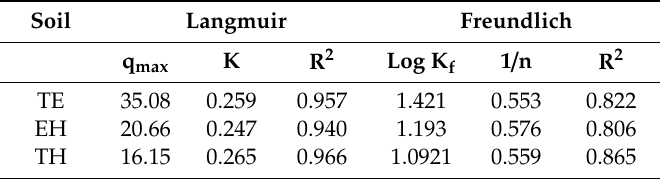
Table 2. Langmuir and Freundlich parameters for the investigated soils. Soil Langmuir Freundlich